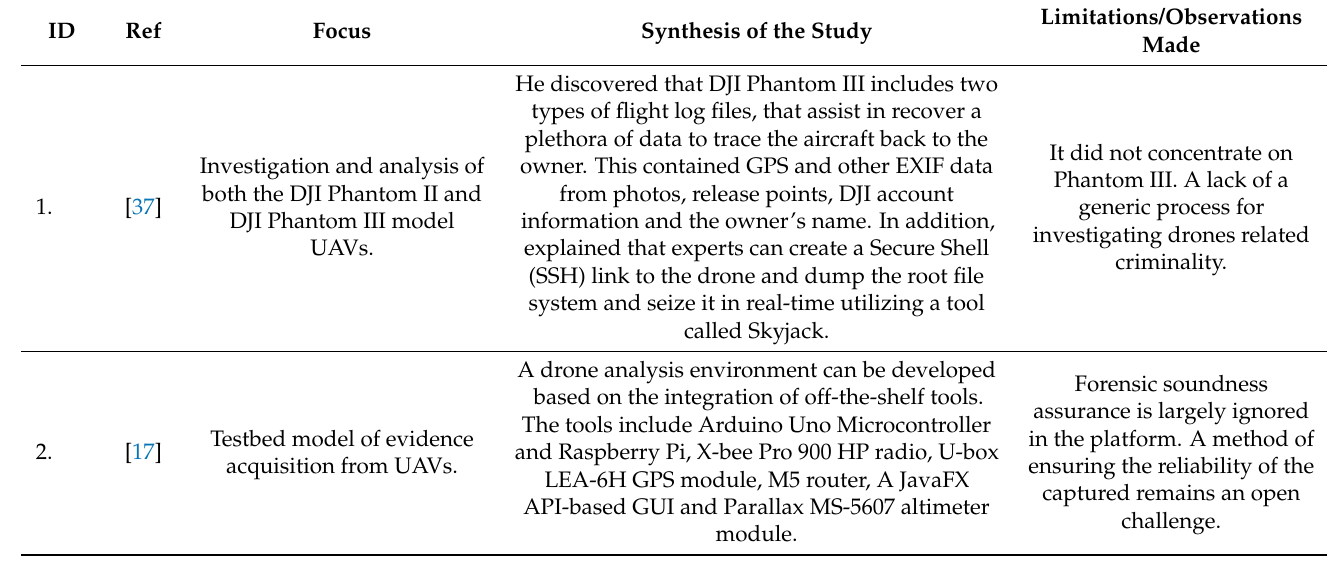
Table 2. A Summary of Articles Focused on